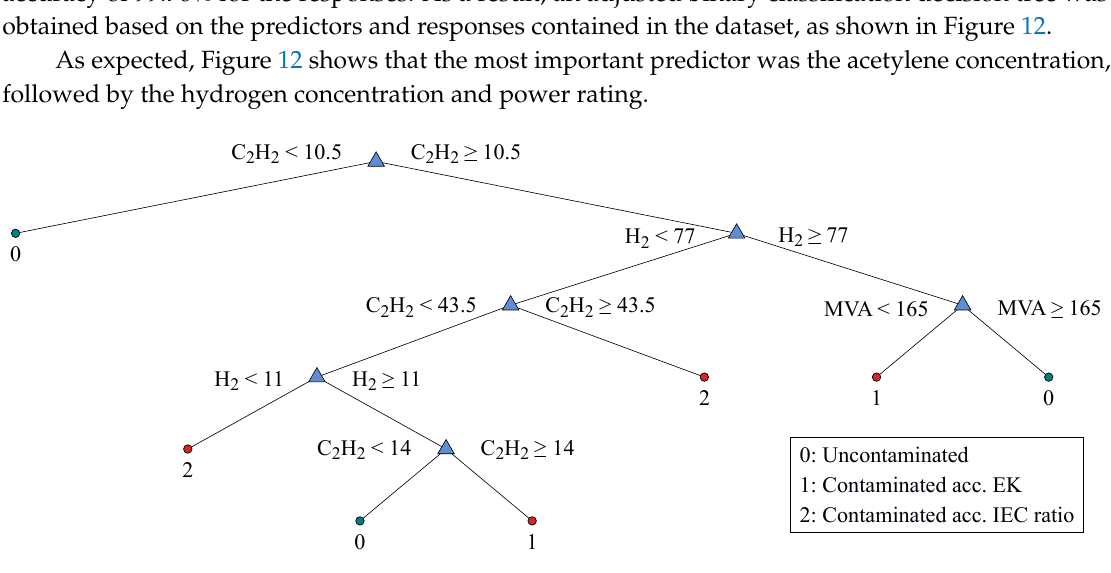
Figure 12. Decision tree obtained from the trained algorithm (concentrations in ppm and power rating in MVA).